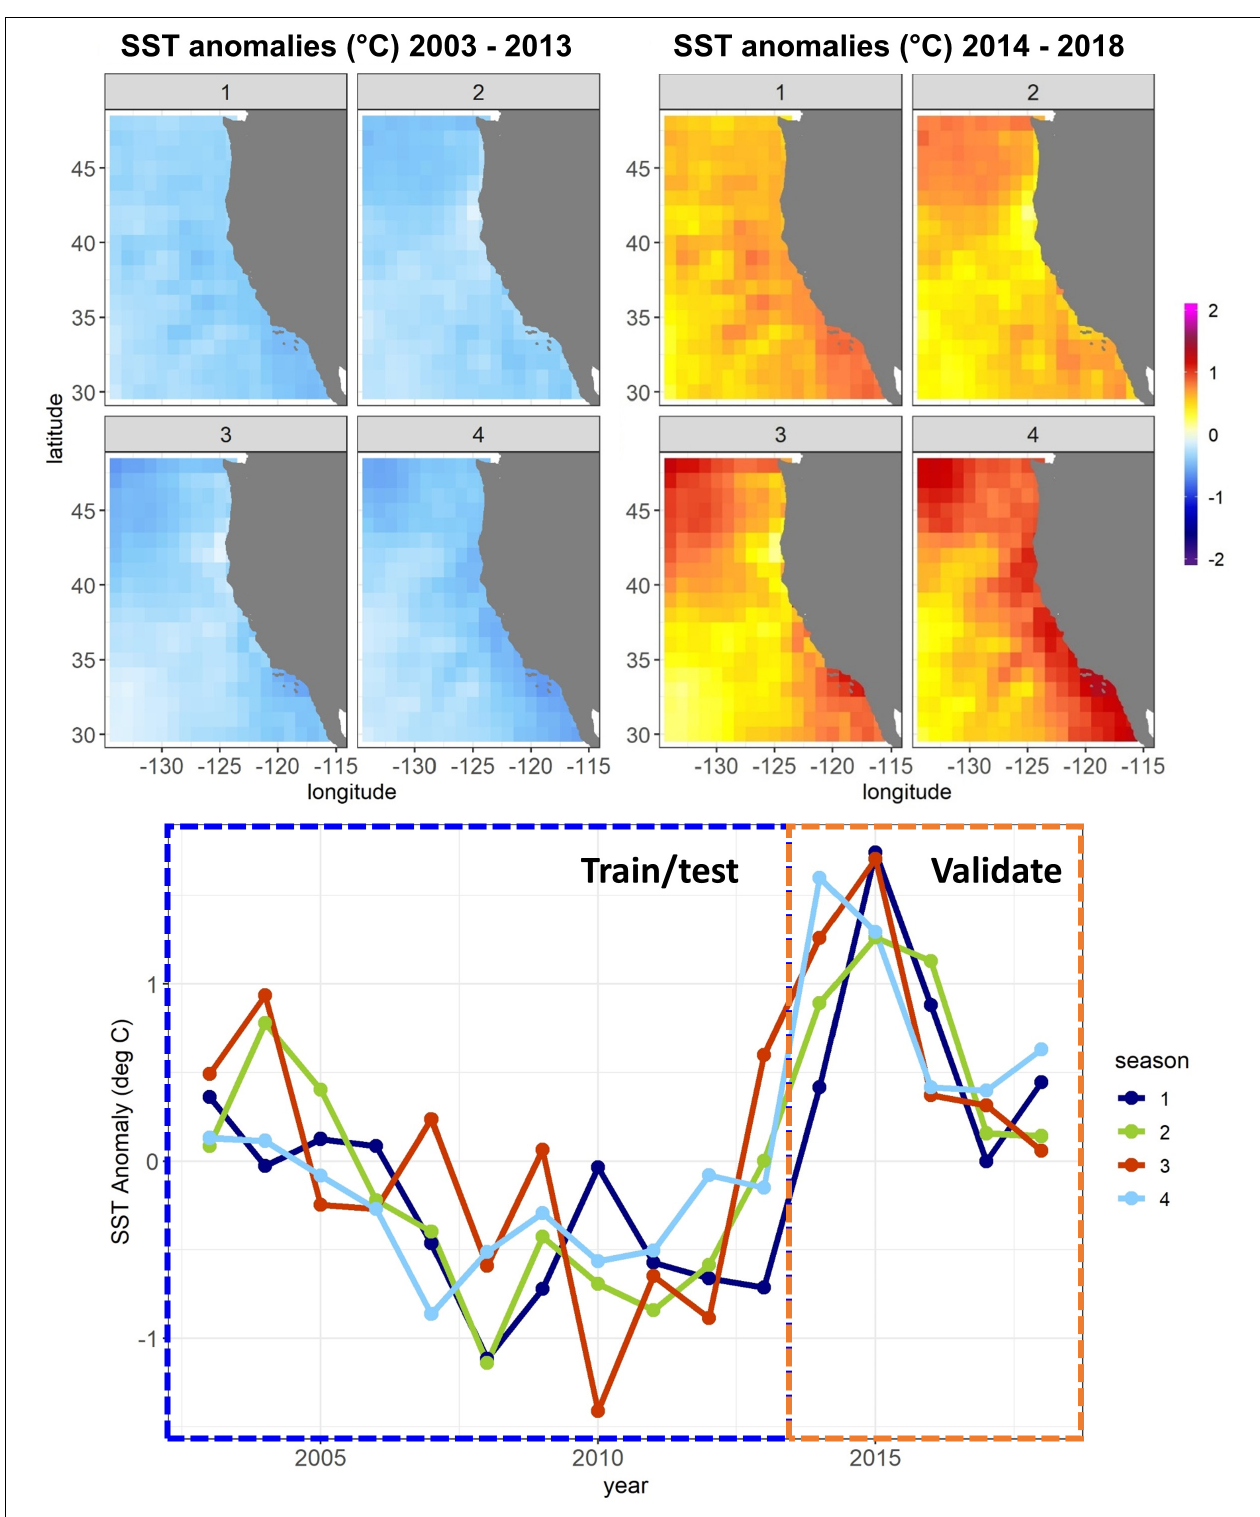
FIGURE 1 | Sea surface temperature (SST) anomalies against a 1980–2018 mean from the CCS ROMS by quarter (January–March, April–June, etc.) for the Experiment 1 SDM training/testing and validation time periods. Anomalies are averaged temporally and mapped spatially at 1 ◦ resolution (top) and averaged spatially across the whole model domain and plotted temporally (bottom)